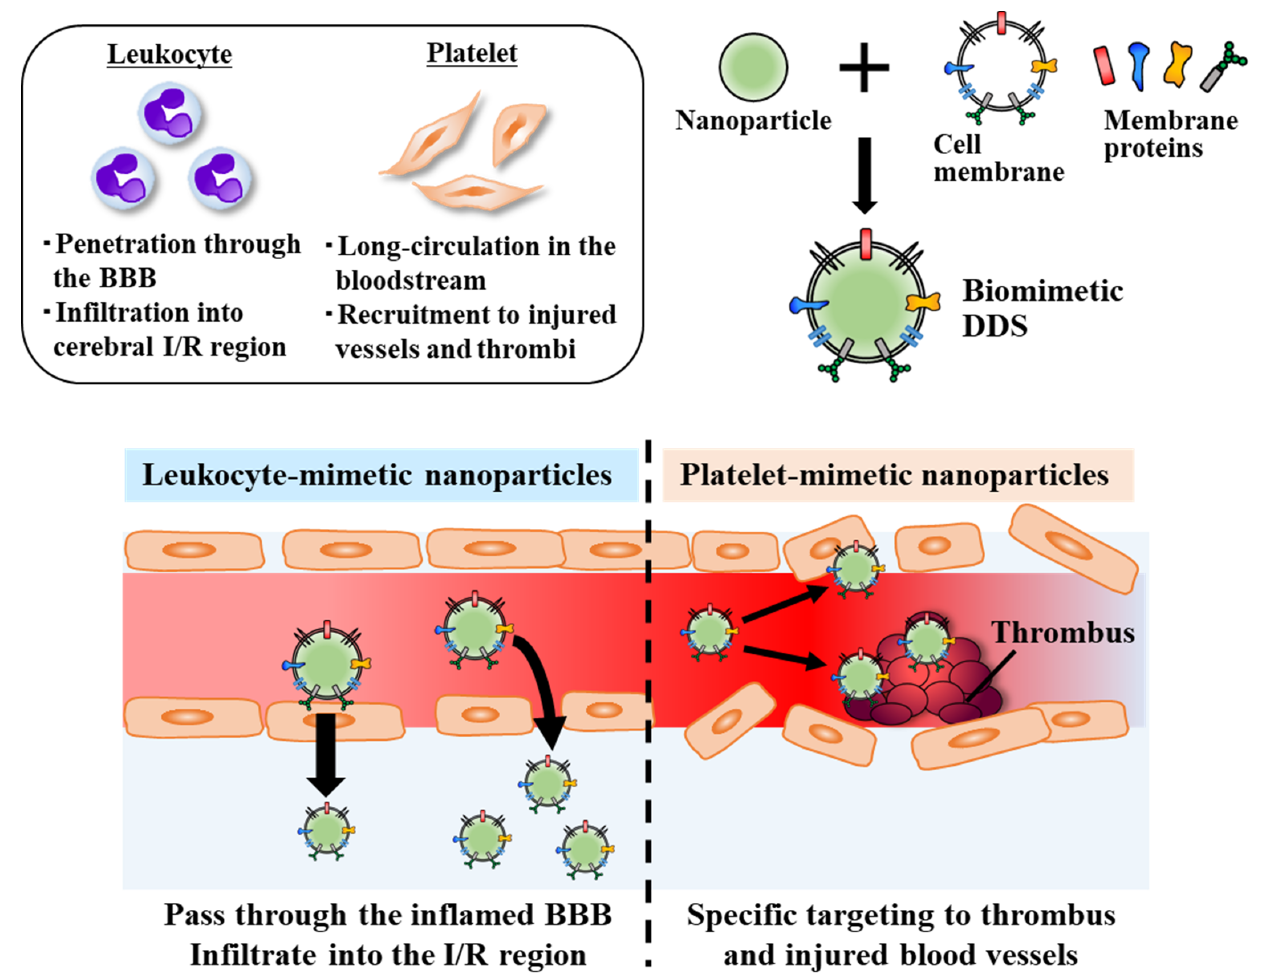
Figure 3. Biomimetic DDS prepared using circulating blood cells (leukocytes and platelets) for the treatment of ischemic stroke.